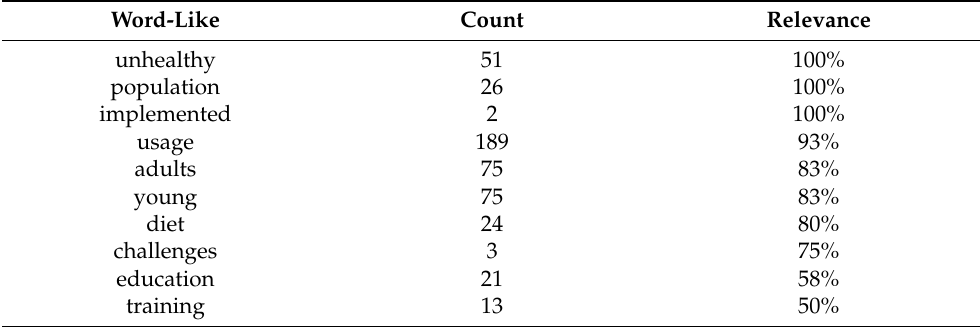
Table 3. Supplement concept associations and probability.